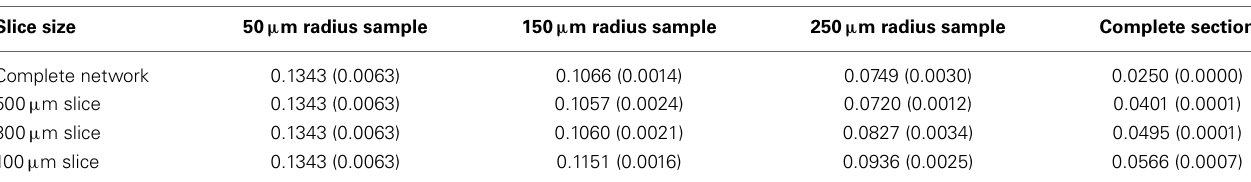
Table 1 | Overall connection fraction (standard error).